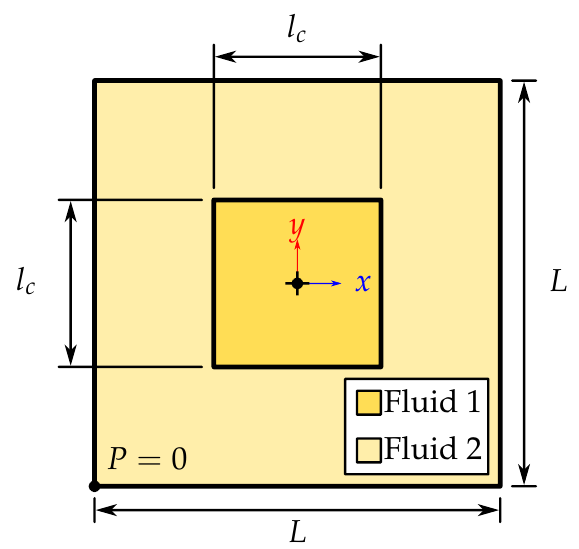
Figure 2. Schematic description of the square droplet case.